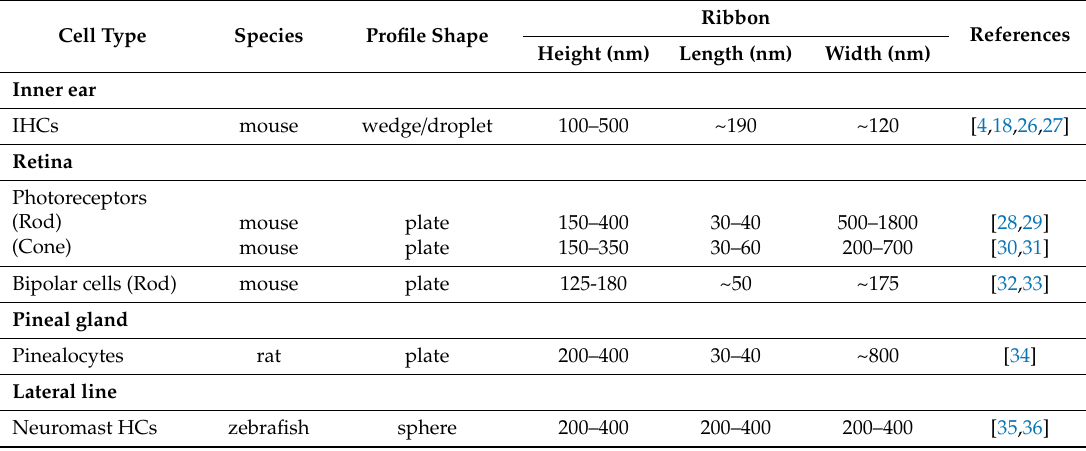
Table 1. Ribbon dimensions in di ff erent sensory cell types and